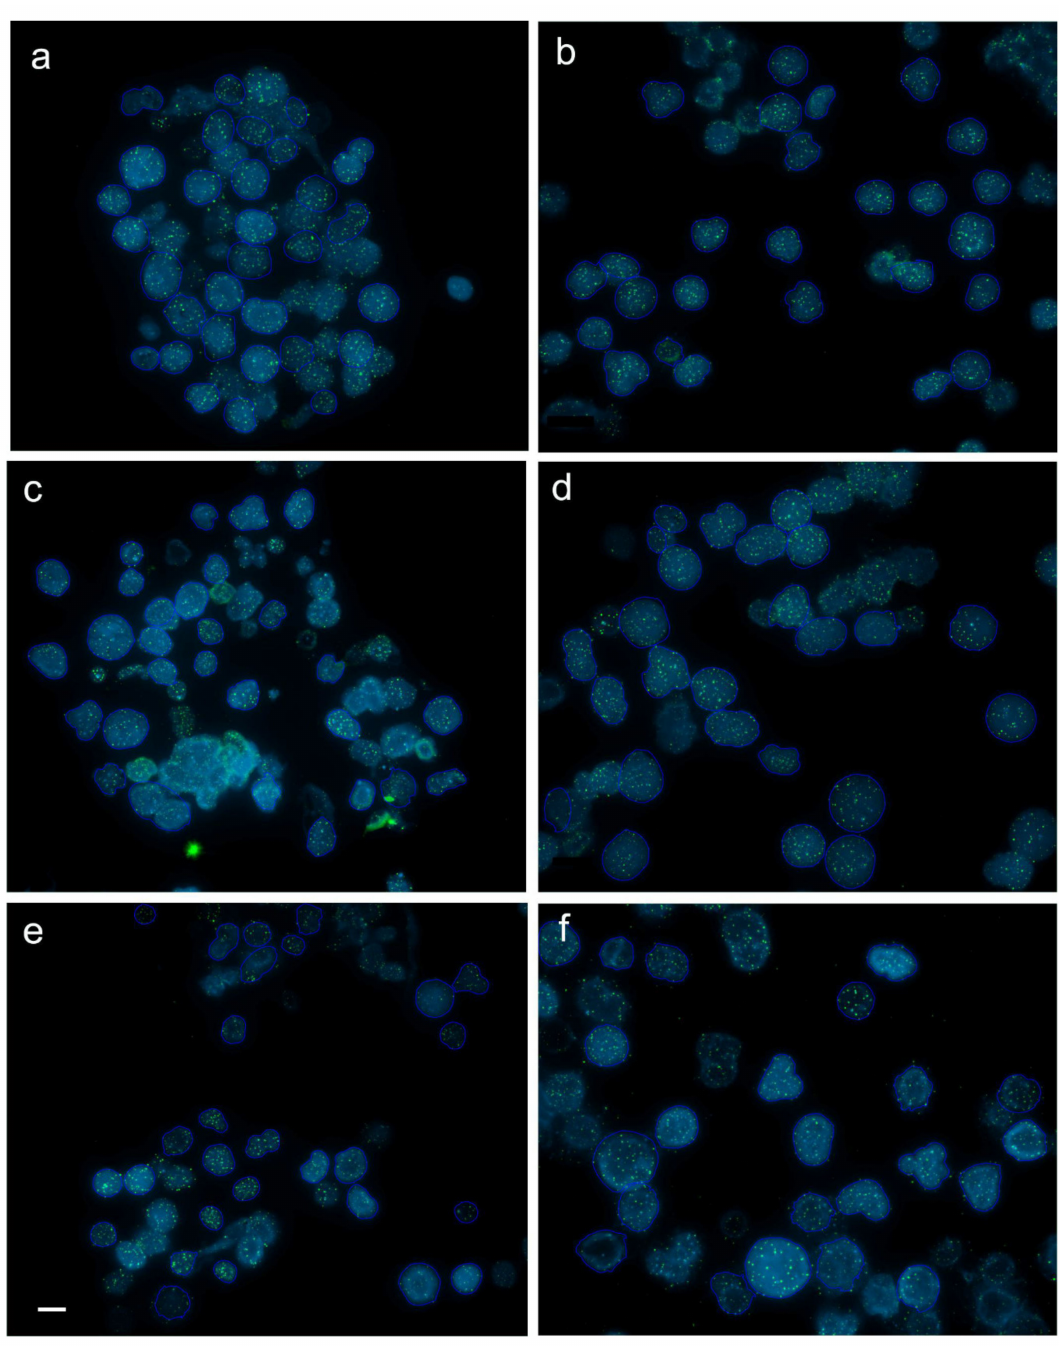
Figure 1. Captured images (frames) with interphase cells from juvenile ( a , b ), subadult ( c , d ) and adult ( e , f ) diploid ( a , c , e ) and triploid ( b , d , f ) rainbow trout after fluorescence in situ hybridization (FISH) with PNA (peptide nucleic acid) telomere probe. Average intensity of telomere fluorescence ( × 10) for cell from the captured frames in juveniles, subadults and adults equaled 18.8 ± 3.3 ( a ) and 18.3 ± 1.8 ( b ), 13.7 ± 1.4 ( c ) and 13.1 ± 1.4 ( d ), 26.3 ± 5.5 ( e ) and 19.3 ± 5.6 ( f ), respectively. Scale bar = 10 µ